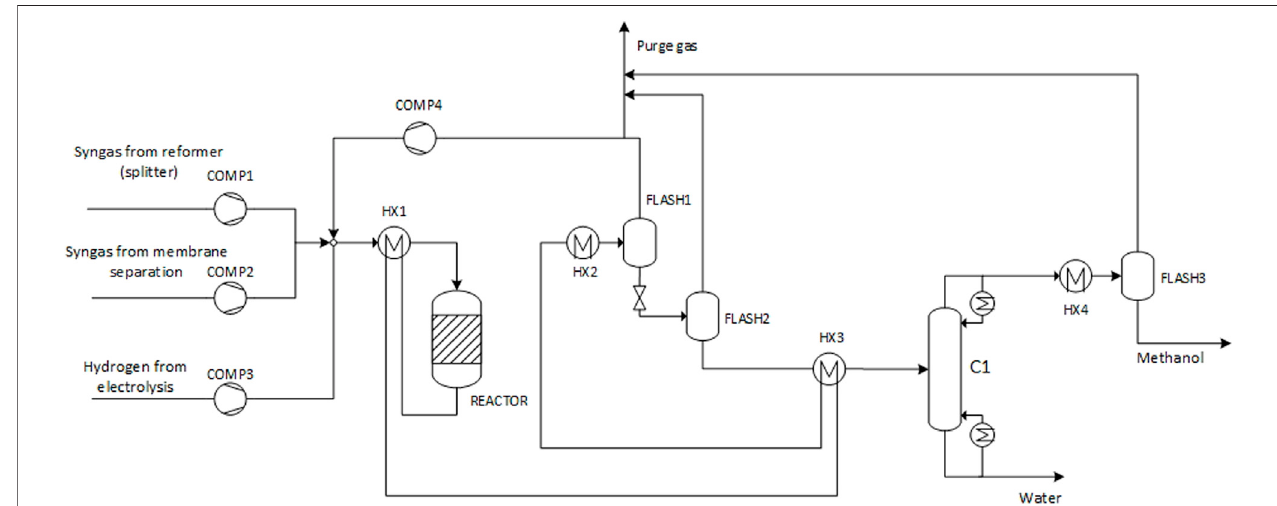
FIGURE 3 | Flowsheet of the methanol synthesis process (case